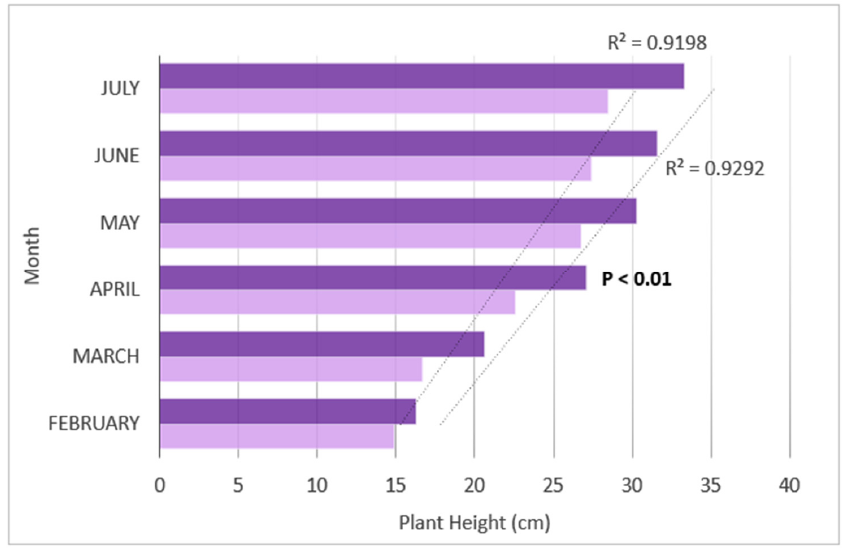
Figure 6. Baccharis pilularis height with unsterilized (dark purple) compared to sterilized (light purple) native soil inoculum.